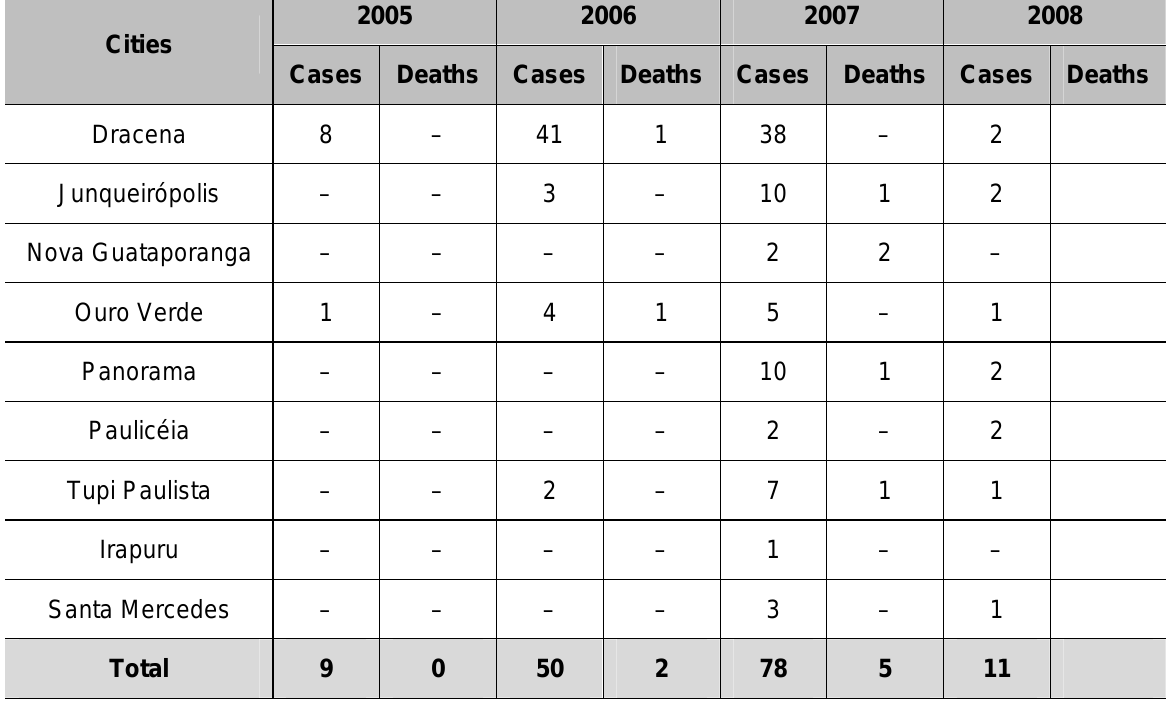
Table 3. AVL cases and human deaths in Dracena microregion, Alta Paulista (SP), from August 2005 to January 2008 2005 Cities Cases